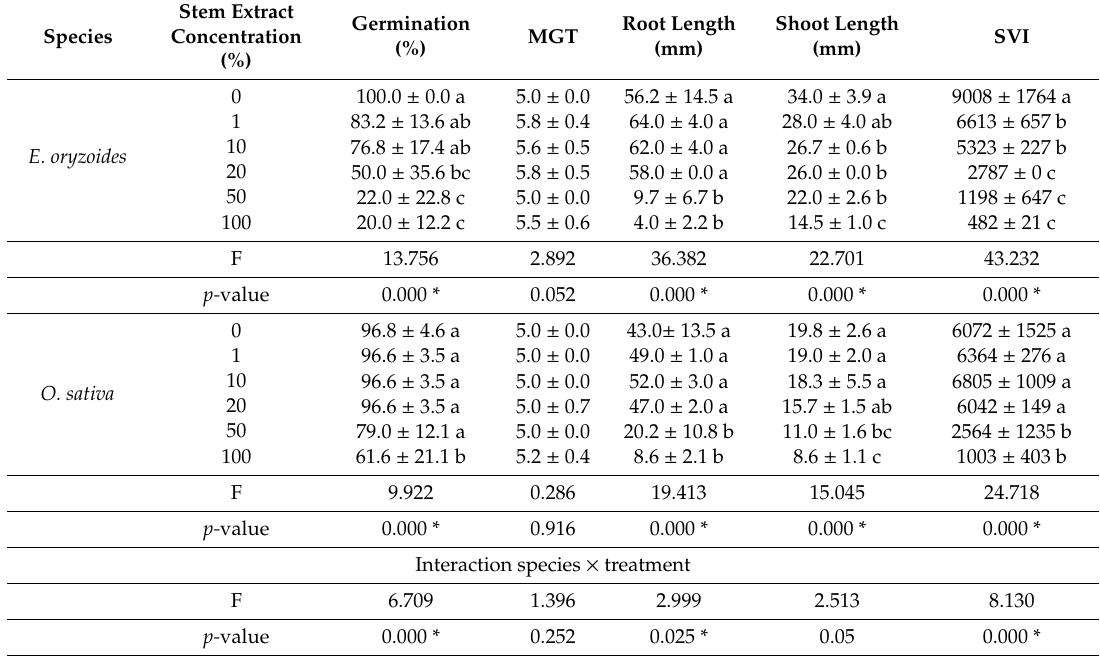
Table 1. Germination indices measured for E. oryzoides and O. sativa under the e ff ect of di ff erent concentrations of L. multiflorum stem